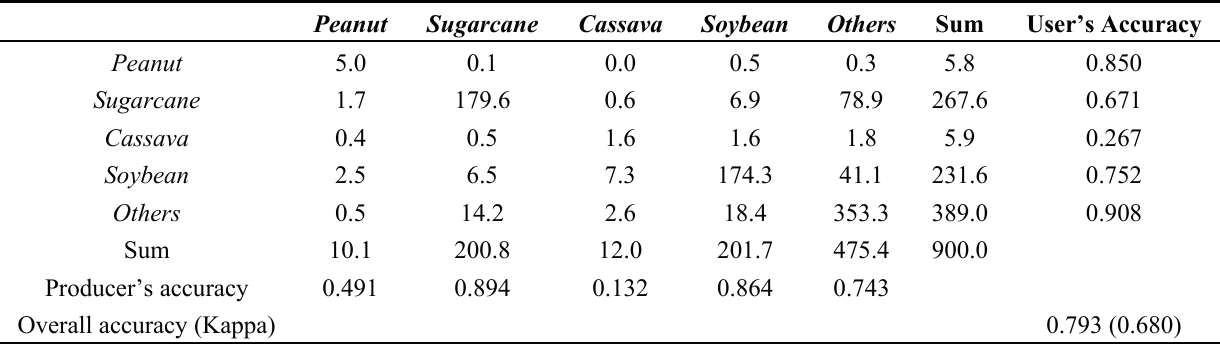
Figure 9. Transferability of models to four test sites with manually delineated reference fields. The OOB overall accuracies obtained for the (point) samples A and B (n = 677) are shown on the y-axis, for (polygon) samples C (n ≈ 1 million pixels) on the x-axis. Each point in the scatter plot corresponds to one combination of scale, shape and compactness (plus feature selection in the RF classifier). In total, results from 1025 different segmentations and classifications are displayed. The best model and the best mapping parameter set are highlighted as red and green points. In addition, the 1-to-1 line and the regression line (in grey) are shown. Table 8. Confusion matrix applying the best model parameter set to the four test sites. The values in the matrix are given in